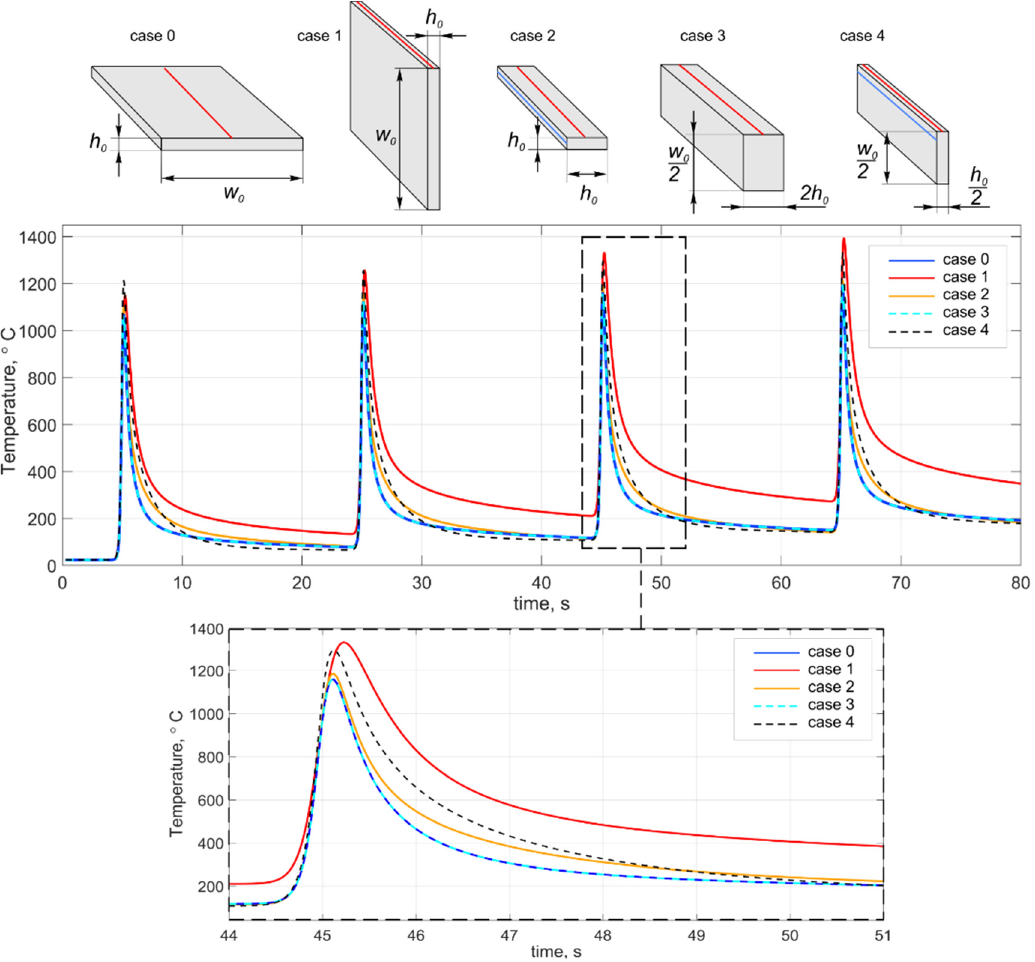
Figure 5. Calculated temperature cycles when replacing an actual substrate with an approximate one (using various approximate calculation schemes).